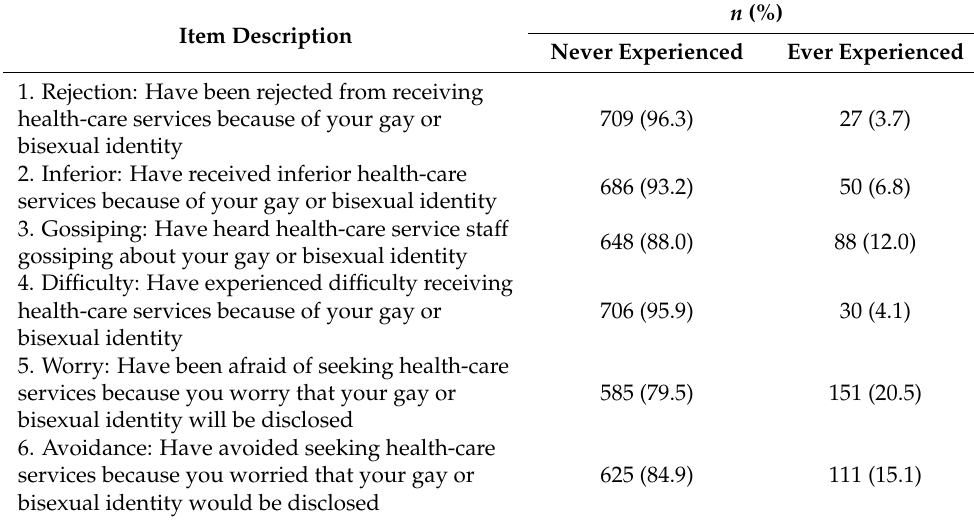
Table 2. Item responses for the Experienced and Anticipated Sexual Stigma Scale in Health-care Services ( n =